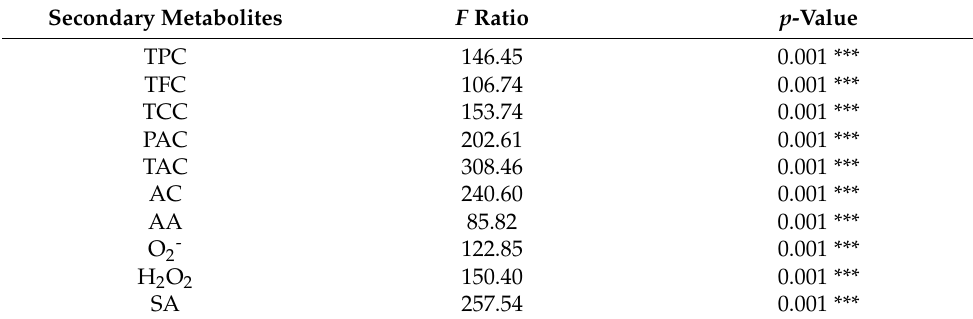
Table 2. Impact of drought stress on secondary metabolic compounds in poplar 717